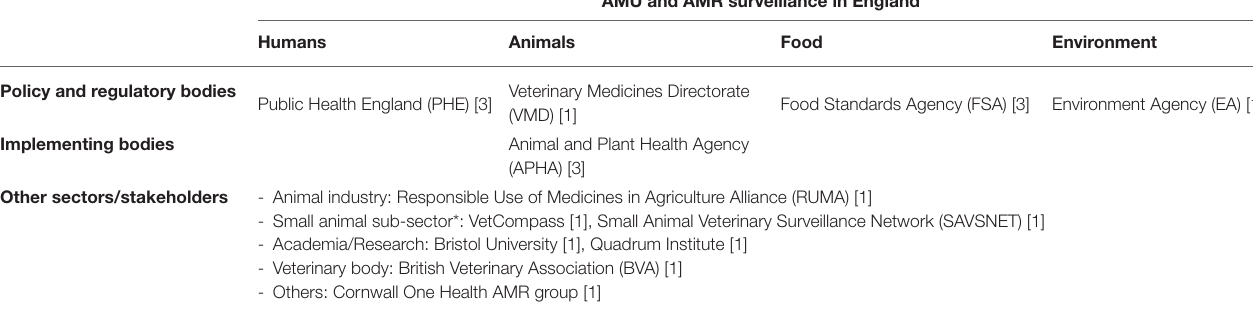
AMU and AMR surveillance in